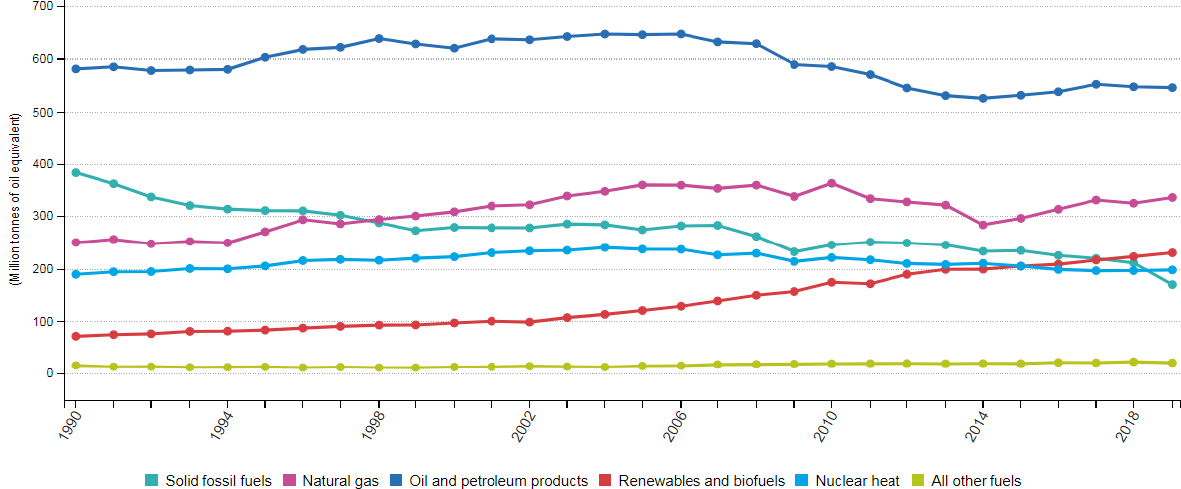
Figure 2. Gross available energy depending on the type of energy source in the EU, in 1990–2019.